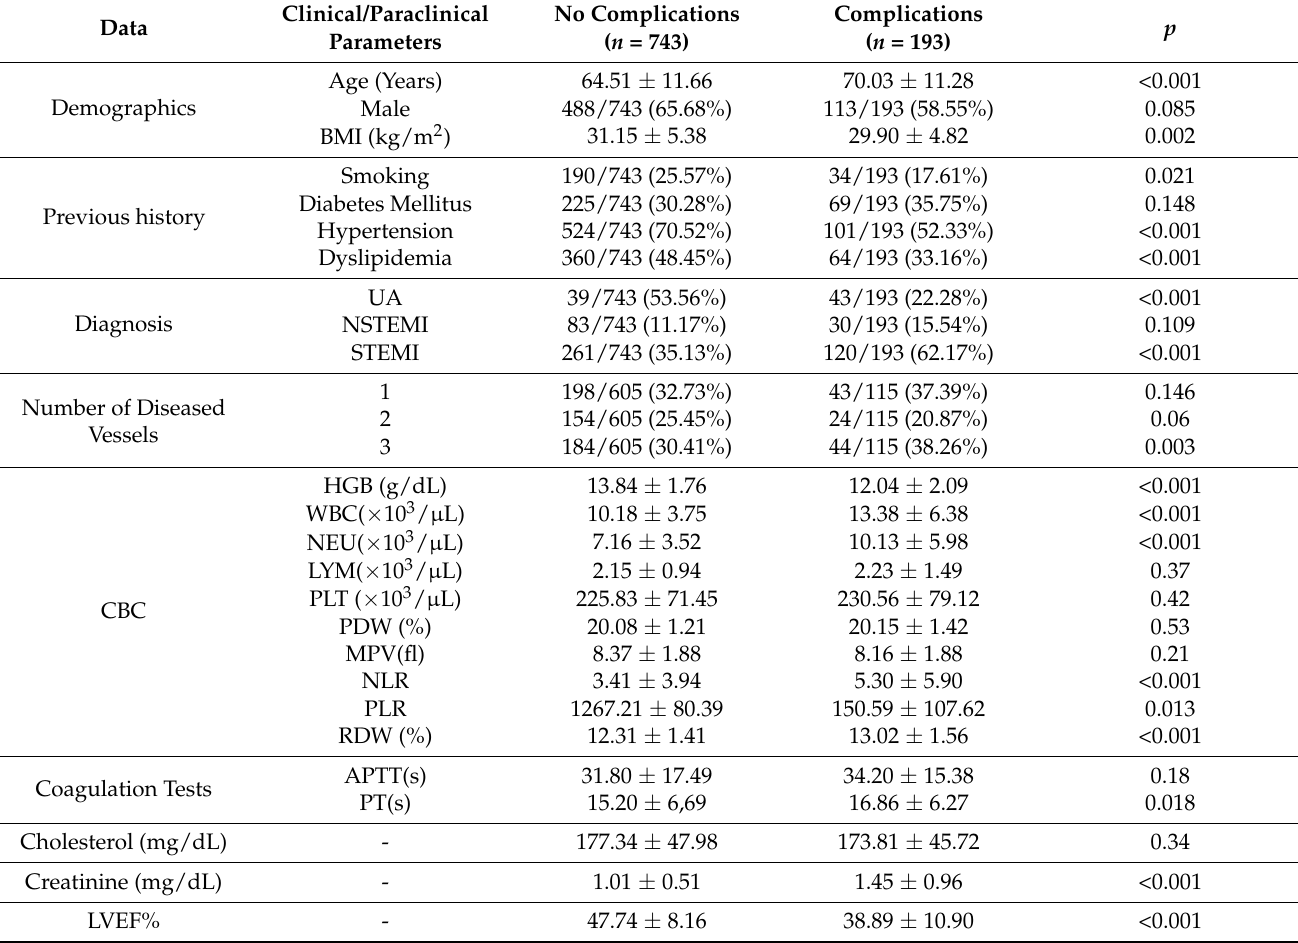
Table 4. Clinical/paraclinical data of the groups with/without in-hospital complications in ACS